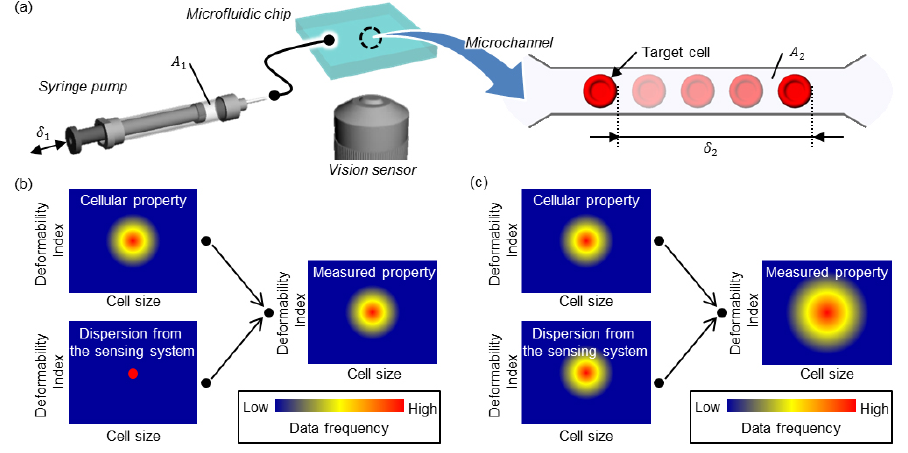
Figure 1. Cell positioning system. ( a ) The overview of the system and an illustration of cell movement in a microchannel and the contribution of system dispersion to the deformability map by using ( b ) a high resolution system and ( c ) a low resolution